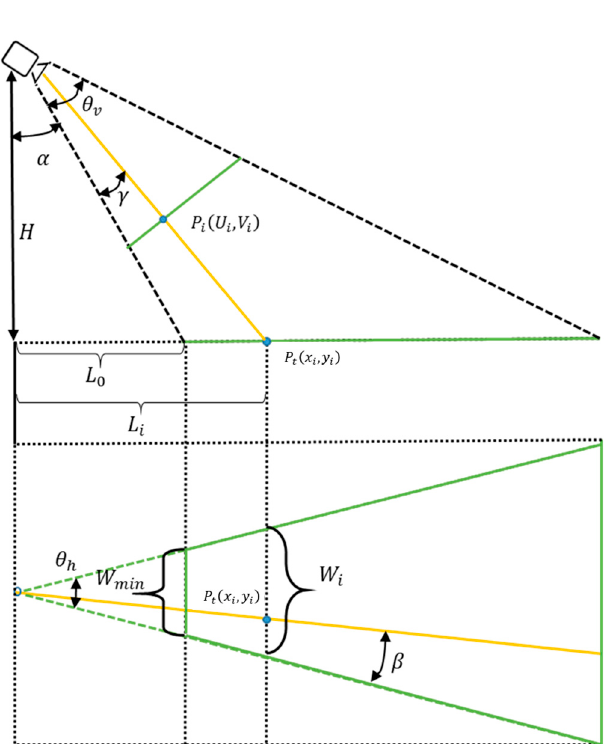
Figure 3. Top view image transformation.